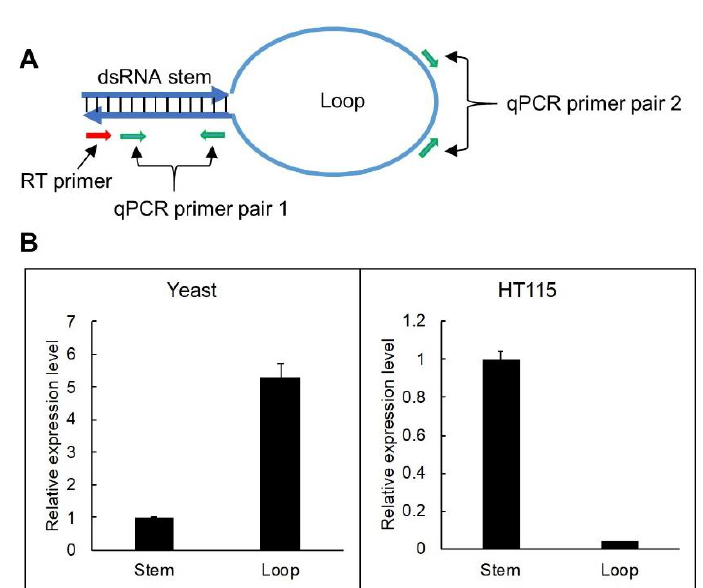
Figure 3. RT-qPCR detects a higher proportion of loop sequence in yeast than in E. coli . ( A ) Locations of RT-PCR primers. ( B ) RT-PCR results showing a higher proportion of amplification of the loop sequence vs dsRNA stem region in yeast than in E. coli . Total RNA samples (2 µ g) from yeast (expressing hpGUS-1) and HT115 (containing the 35S-driven hpGUS-1) were analyzed, with three technical replicates for the qPCR reaction. The same RNA samples (2 µ g) without DNase treatment and Superscript III reverse transcription were used as reference for qPCR normalization. Note that the value “1” for stem amplification is arbitrary, and the abundance of yeast and HT115-expressed dsRNA cannot be compared using this data because there is no common reference